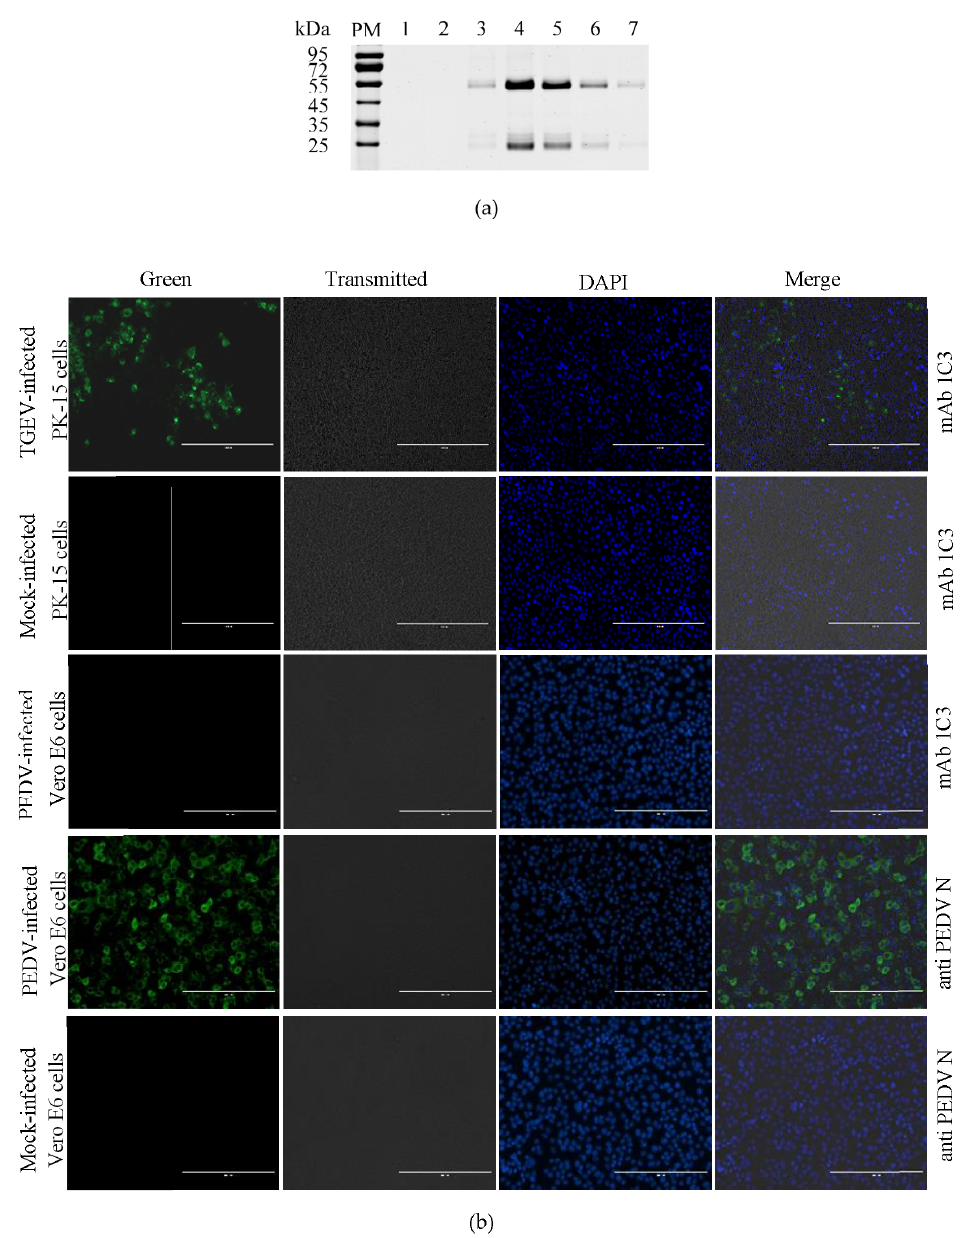
Figure 6. Optimization of the IFA method using mAb 1C3 for the M protein. ( a ) Purification of mAb 1C3 IgG. Lanes 1–7: purified IgG; ( b ) Optimization of the IFA method for M protein detection using the purified mAb 1C3 IgG in PK-15 cells. PM represents protein